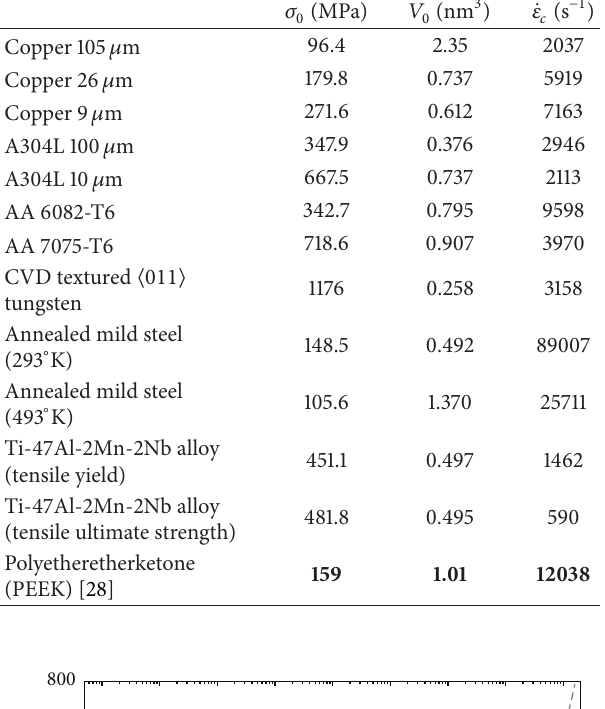
Table 3: Optimized material constants for several metallic materi- als.